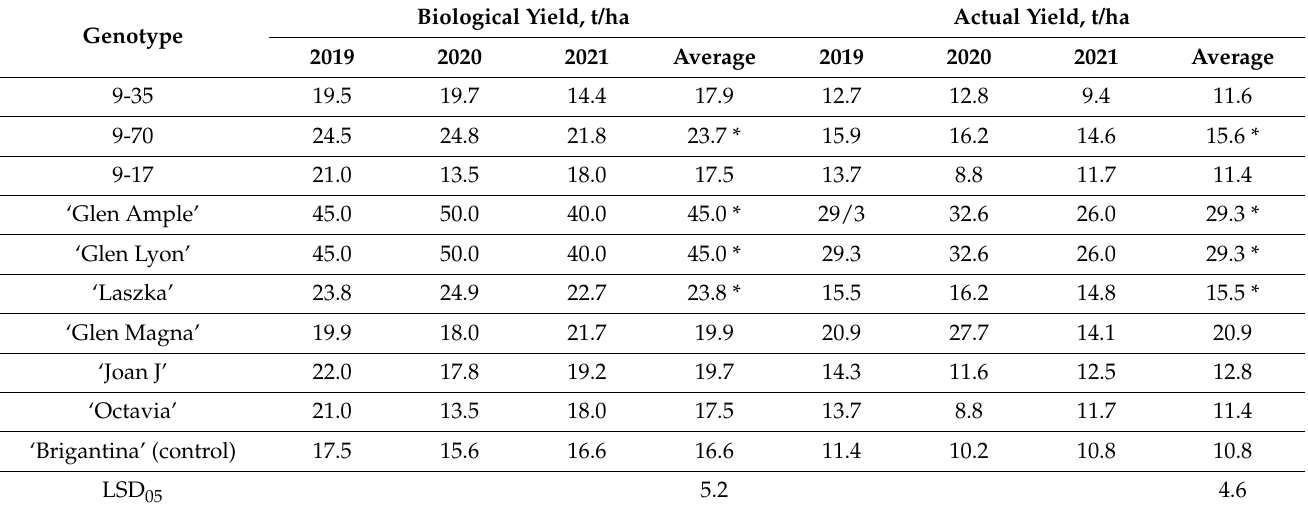
Table 8. Raspberry yield, t/ha (2019–2021).